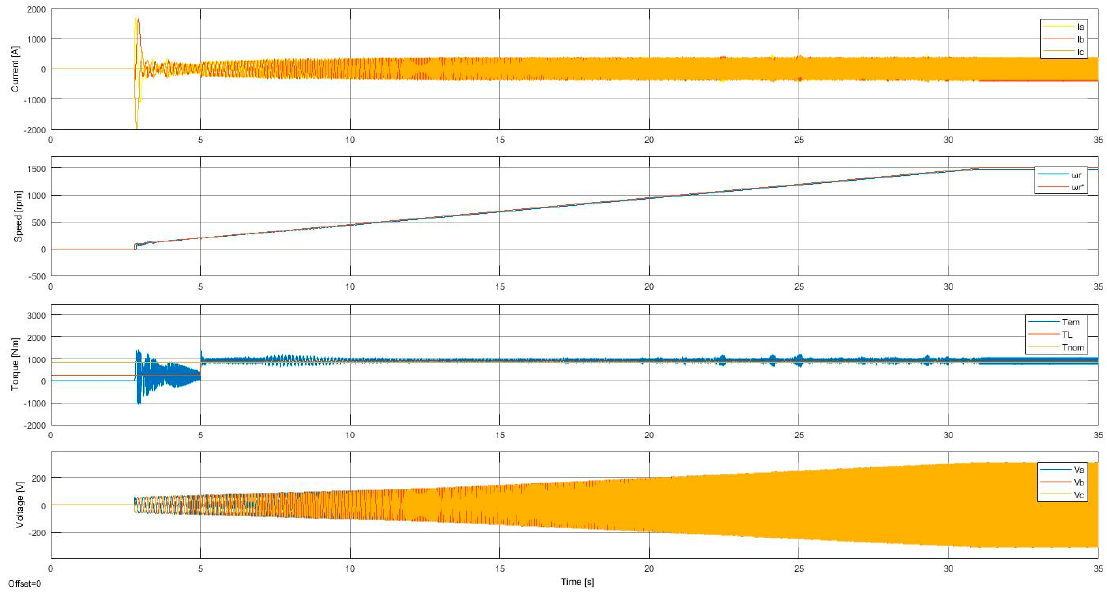
Figure 4. Real-time simulation results of the basic SCS for a 200 HP IM.